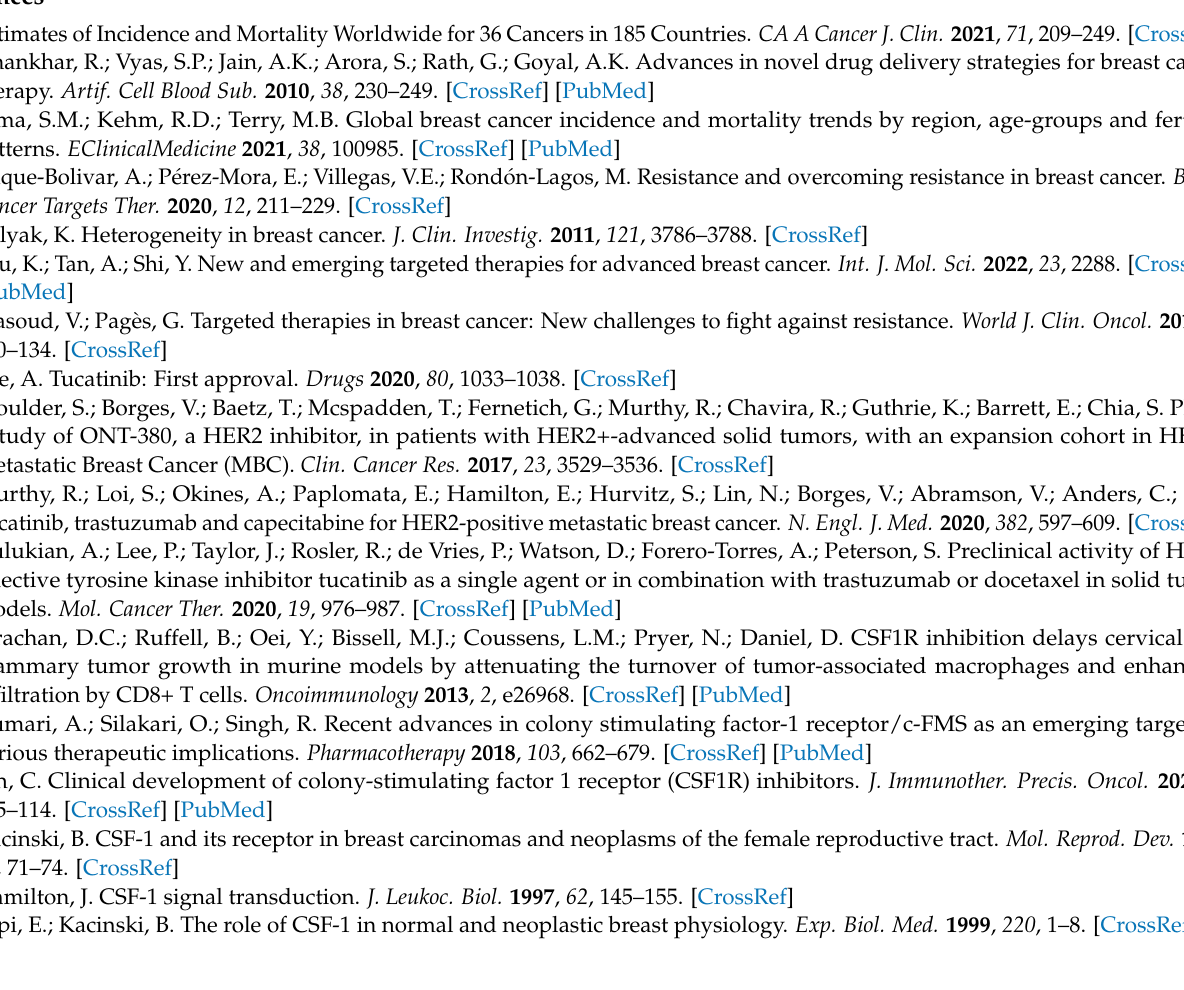
Table S2: One-way ANOVA of four kusunokinin isomers docking score to the same protein, Table S3: Reference- and MD rearranged-residue number of CSF1R kinase domain, Figure S1: Selected candi- date proteins binding pocket alignment, Figure S2: Alignment of docking structure to the reported crystal